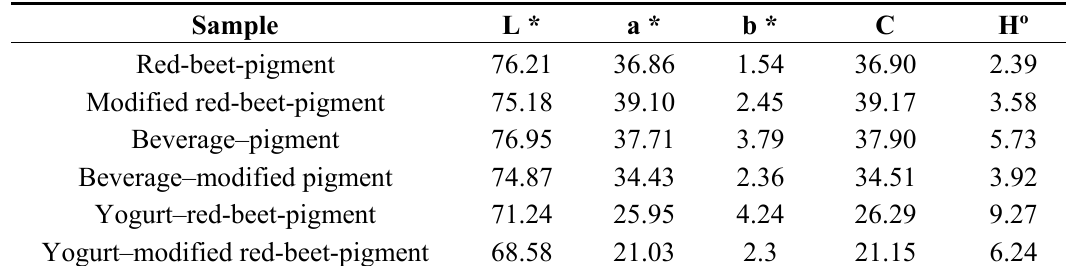
Table 2. Color analysis for unmodified and modified red beet pigments applied to beverage and yogurt model